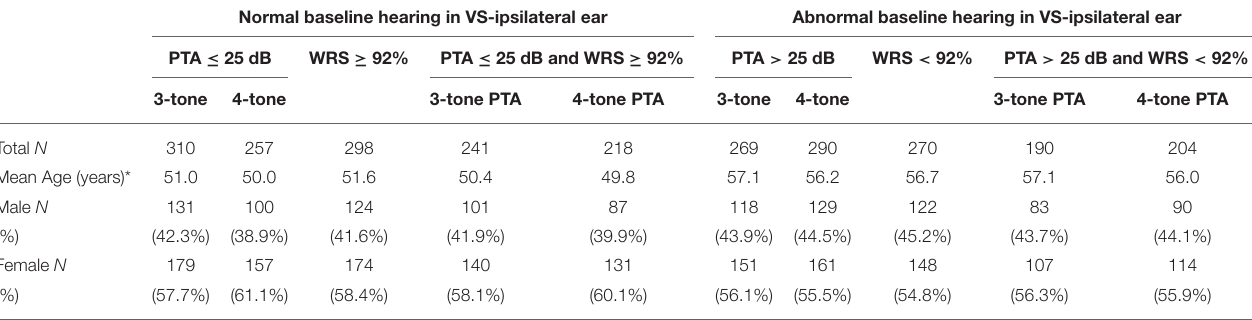
TABLE 3 | Demographics in patients with sporadic unilateral VS, segmented by baseline VS-ipsilateral hearing. Normal baseline hearing in VS-ipsilateral ear Abnormal baseline hearing in VS-ipsilateral